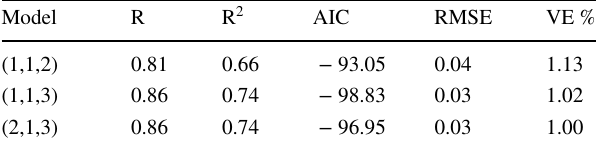
Table 1 The consequences of TDS group, order (1,3)